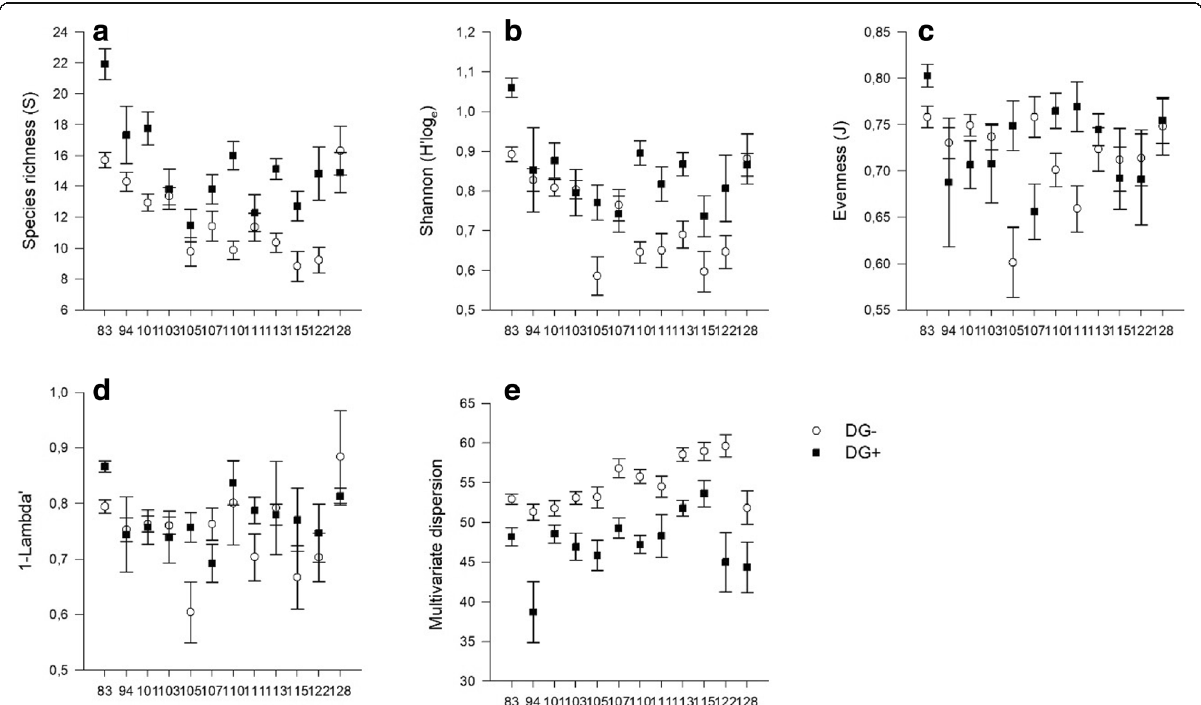
Fig. 3 Effect of D. geminata on different components of the diversity ( a ) species richness, ( b ) shannon diversity, ( c ) evenness, ( d ) Simpson index and ( e ) β - diversity of benthic diversity in invaded (black symbols) and not invaded (white symbols) in the different basins. Biobio River Basin (83), Tolten River Basin (94), Valdivia River Basin (101), Bueno River Basin (103), Puelo River Basin (105), Yelcho River Basin (107), Palena and coastal Rivers in the Southern Limit of